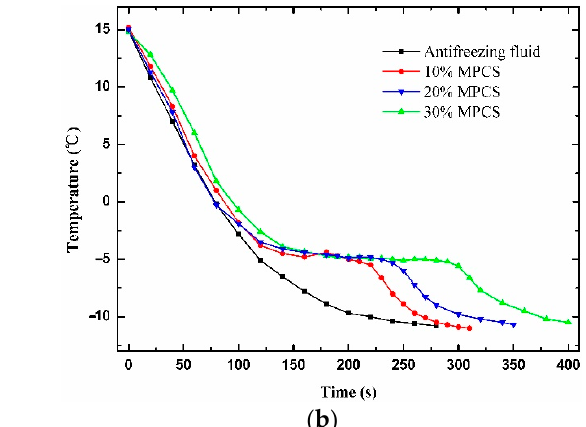
Figure 12. Temperature of antifreeze fluid and different mass concentrations of MPCS under ( a ) heating and ( b ) cooling process.